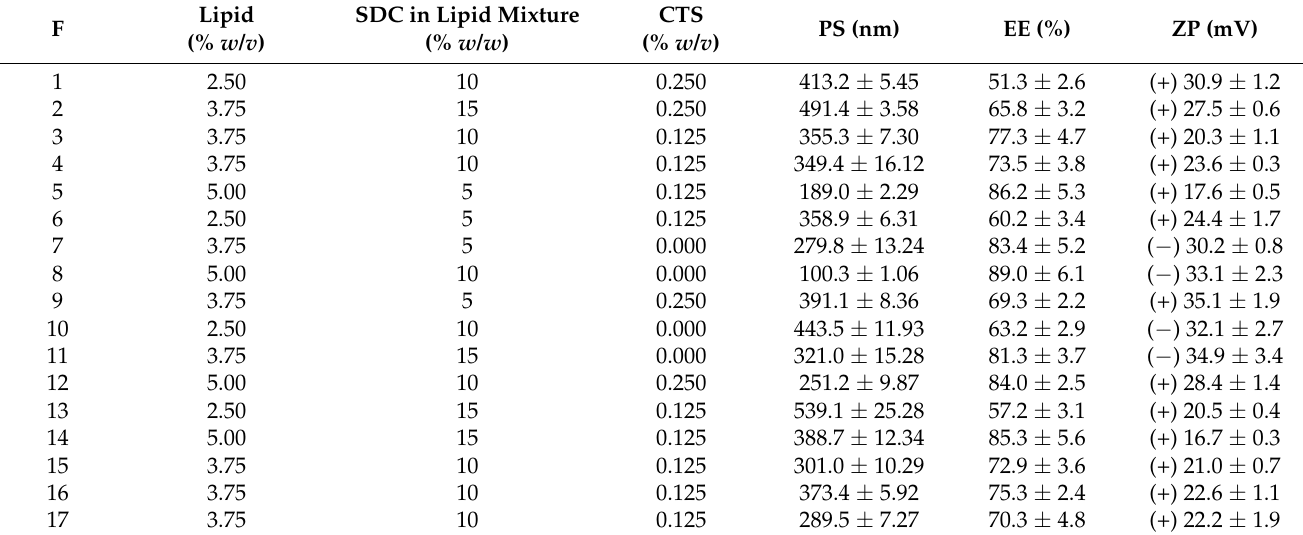
Table 2. The composition of the different experimental runs and the results of response variables of BER-CTS-BLS